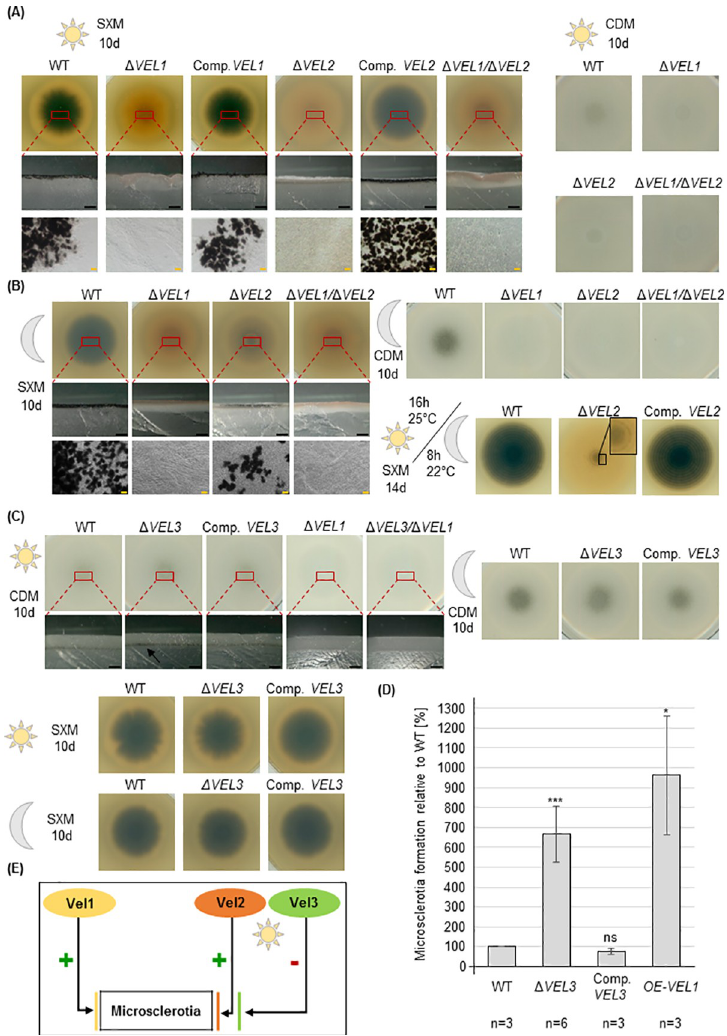
Fig 2. V . dahliae microsclerotia formation depends on Vel1 with Vel2 as additional positive and Vel3 as negative control regulator primarily in light. 5x10 4 spores of the indicated strains were spotted on indicated plates (SXM: simulated xylem medium; CDM: minimal Czapek-Dox-Medium) and incubated for 10 days at 25˚C. Single colonies on SXM are shown from the back and colonies on CDM are shown from the top of the plate. Cross sections were made through the middle of the colony. Microscopy images show colony material scraped from the surface. (A) Vel1 and Vel2 are required for microsclerotia development in the presence of light. Microsclerotia formation of the Δ VEL1 or Δ VEL2 strains was compared to wild type (WT) and respective complementation strains (Comp.) on single colony pictures (first row), cross sections (second row) and in micrographs (third row). (B) Vel1 is primarily required for microsclerotia formation in darkness with a smaller contribution of Vel2. Incubation as in (A) but in darkness instead of light. Wild type as well as the VEL2 deletion strain produce microsclerotia in darkness, but absence of VEL2 leads to reduced amounts of microsclerotia. Lower right part: Vel2 function is independent of the fungal light/dark control. Phenotypical analysis during long day/night cycling conditions (16 h, 25˚C: 8 h, 22˚C, light: dark). Wild type displays a ring-like structure around the inoculation point with melanized microsclerotia and reduced color of the microsclerotia towards the margins of the colony. The VEL2 deletion strain is also capable to form the ring-like structure but with hardly any melanization (black box). (C) Vel3 inhibits microsclerotia formation in light without strong impact in dark on minimal medium. Colony pictures (first row) and cross sections (second row) are shown. Black scale bar = 1 mm, yellow scale bar = 20 μ m. (D) Microsclerotia quantification of the wild type, the VEL3 deletion and complementation strain as well as the VEL1 overexpression strain. The VEL3 deletion and the VEL1 overexpression strains produce significantly more microsclerotia than the wild type and complementation strain. The experiment was repeated three times with three technical replicates each. Significant differences to wild type were calculated by t-test and indicate � : p < 0.05; ��� :p < 0.001; ns: not significant. (E) Interplay between the velvet domain proteins Vel1, Vel2 and Vel3 in V . dahliae microsclerotia formation in the presence or absence of